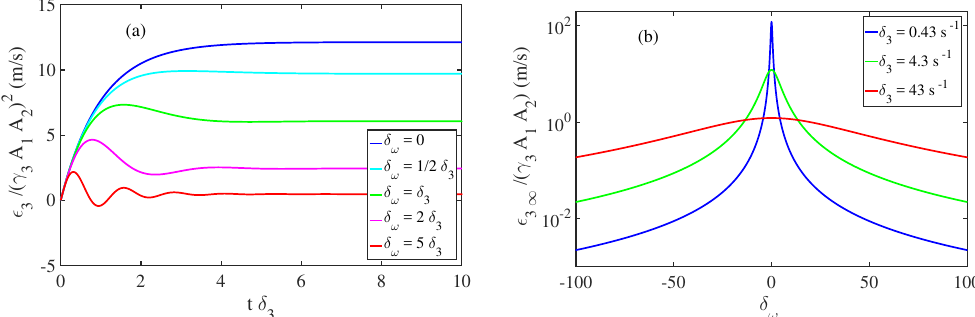
Figure 13. ( a ) (cid:101) 3 / ( γ 3 A 1 A 2 ) 2 as a function of t δ 3 for a few values of δ ω using Equation (89). The pa- rameters of the daughter wave correspond to a capillary wave of frequency f 3 = 33Hz, wavenumber k 3 = 834m − 1 , and dissipation rate δ 3 = 4.25s − 1 . ( b ) (cid:101) 3 ∞ / ( γ 3 A 1 A 2 ) 2 as a function of δ ω for a few values of δ 3 , according to Equation